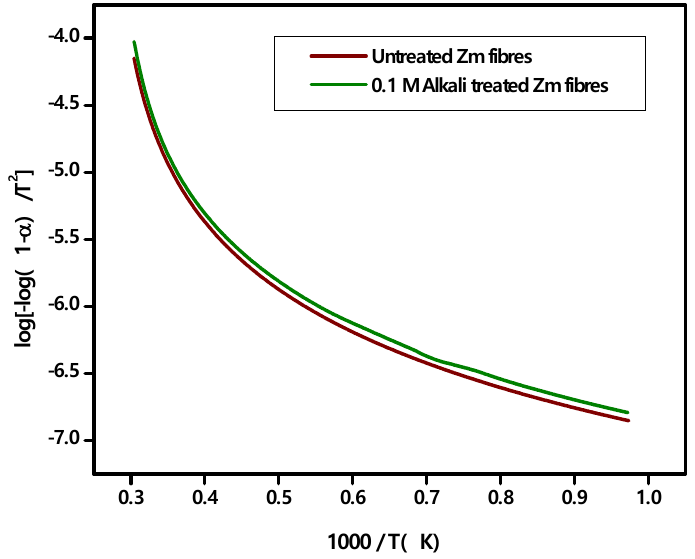
Figure 11. Coats-Redfern plot for raw and alkali treated Zm fibres. The kinetic activation energy of Zm fibres (63.48 KJ/mol) and alkali treated Zm fibres (64.13 KJ/mol) are comparable to Indian areca fruit husk fibres (64.54 kJ/mol), Saharan aloe vera cactus (60.2 KJ/mol), Lygeum spartum (68.77 kJ/mol) and root fibres of Ficus religiosa (68.02 kJ/mol). The activation energy is higher for Derris scandens (73.2 kJ/mol), Cissusquadrangularis root fibres (74.18 kJ/mol), Prosopis juliflora bark fibres (76.72 kJ/mol) and Nendran banana fibres (89 kJ/mol) [22,25,26,32,53,55,57].